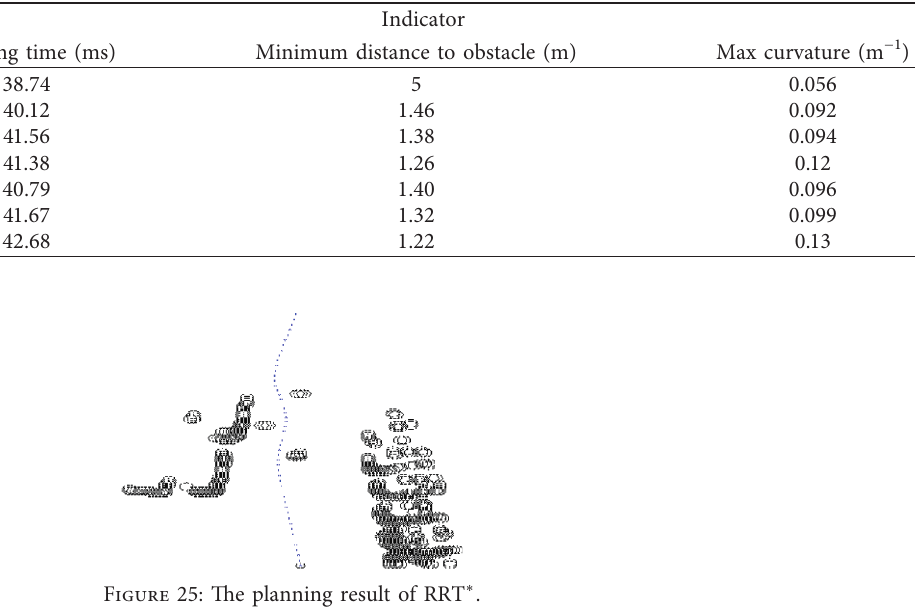
Table 4: The main evaluation indicators of path planning results in low-level model.